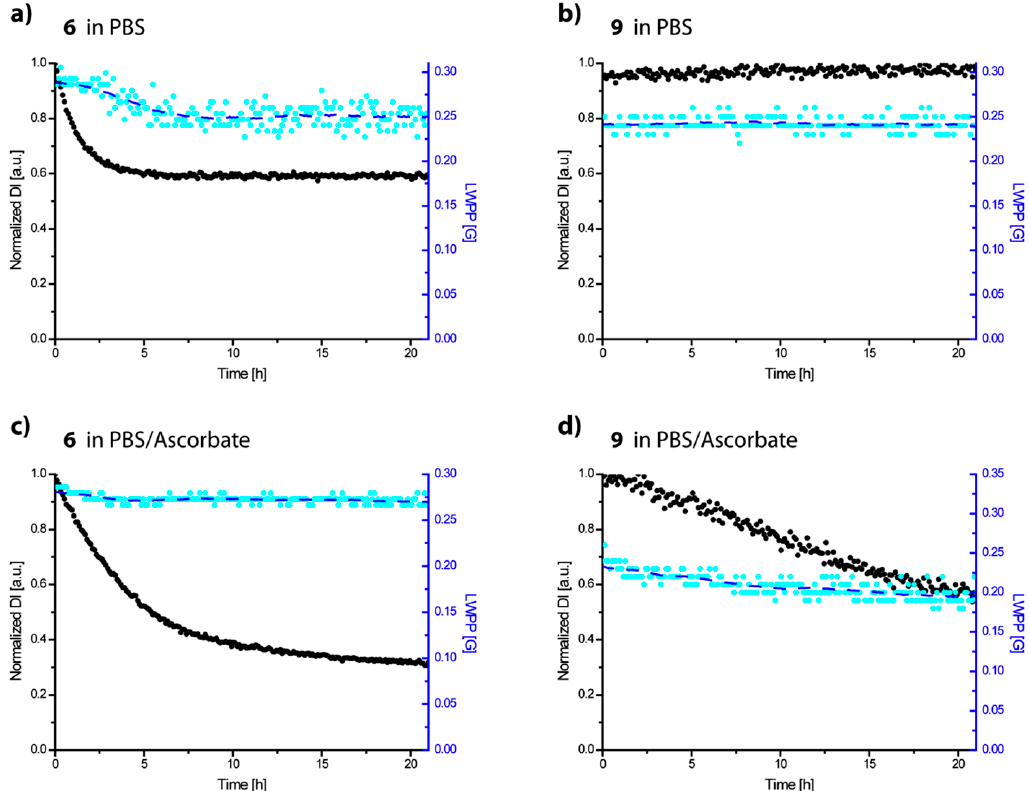
Figure 3. The stability of trityl labels 6 and 9 . The normalized double integral values (black), peak-to-peak line width values (cyan) of 200 µ M gas tight incubations of 6 ( a , c ) and 9 ( b , d ) in PBS bu ff er and in PBS bu ff er with 5 mM ascorbate. EMXmicro acquisition parameters: modulation amplitude: 0.1 G, microwave power: 558 µ W, time constant: 20.48 ms, sweep time: 69.02 s, resolution: 100 Pts / G for 6 and 154 Pts / G for 9 , sweep width: 20 G.